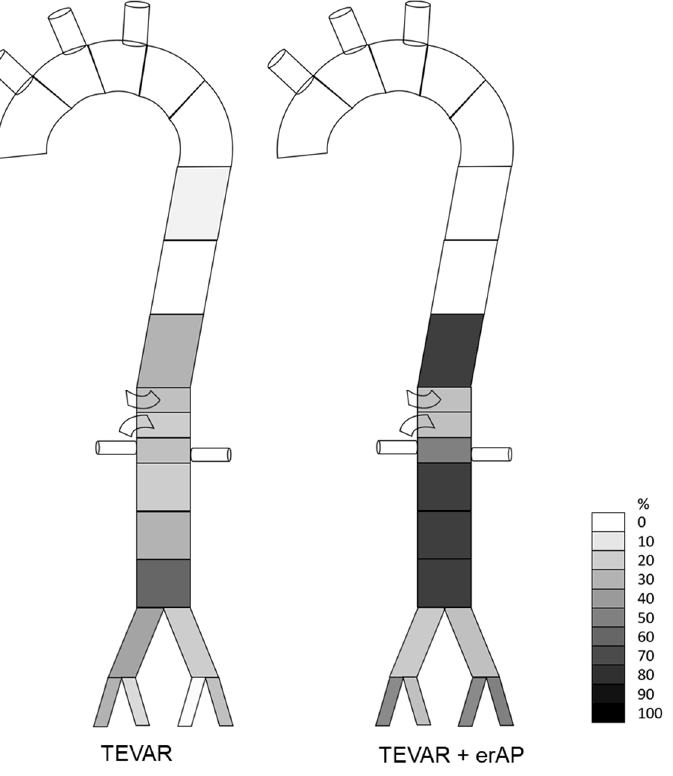
Figure 6. Cumulative frequencies of true lumen collapse, comparing cases treated with TEVAR alone with TEVAR + erAP cases.